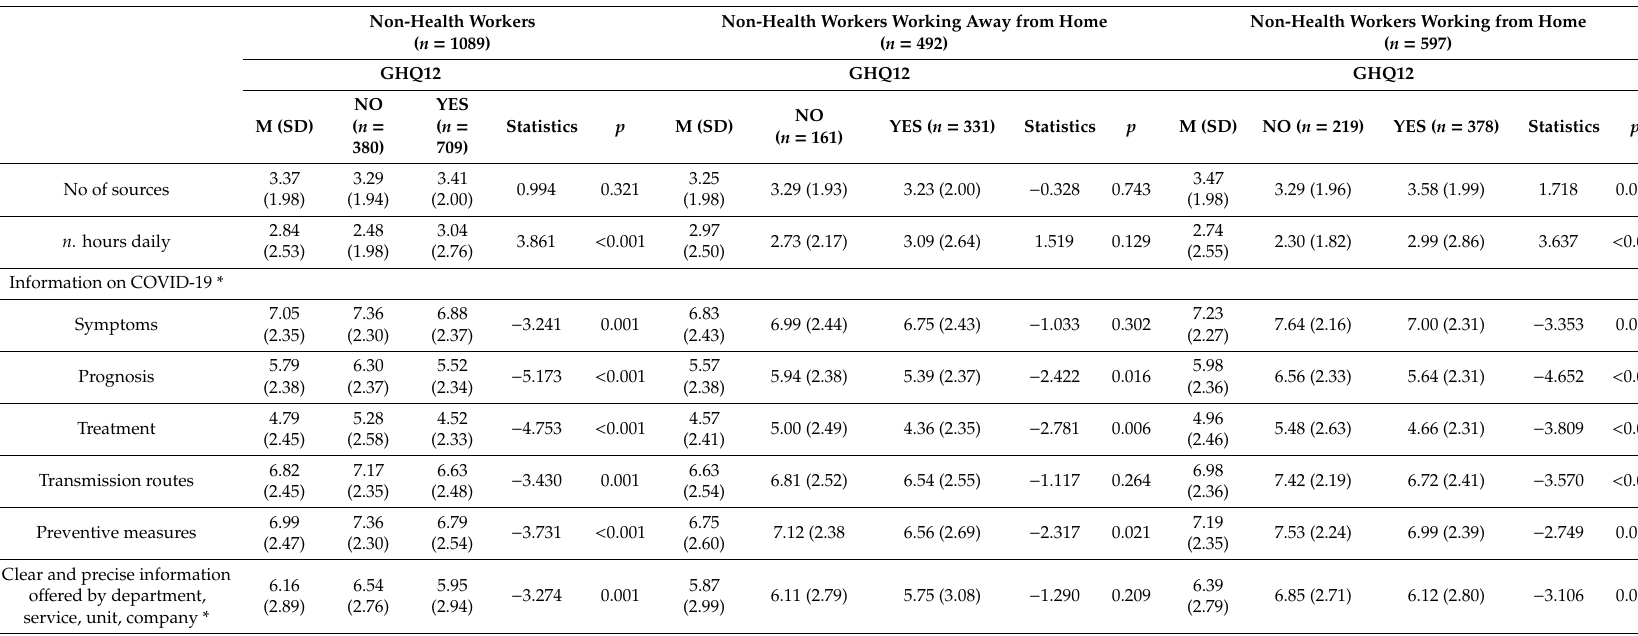
Table 3. Sources of information, and time devoted to them, about the pandemic and psychological distress among non-health workers working during the pandemic. Non-Health Workers Non-Health Workers Working Away from Home Non-Health Workers Working from Home ( n = 1089) ( n = 492) ( n = 597) GHQ12 GHQ12 GHQ12 Statistics